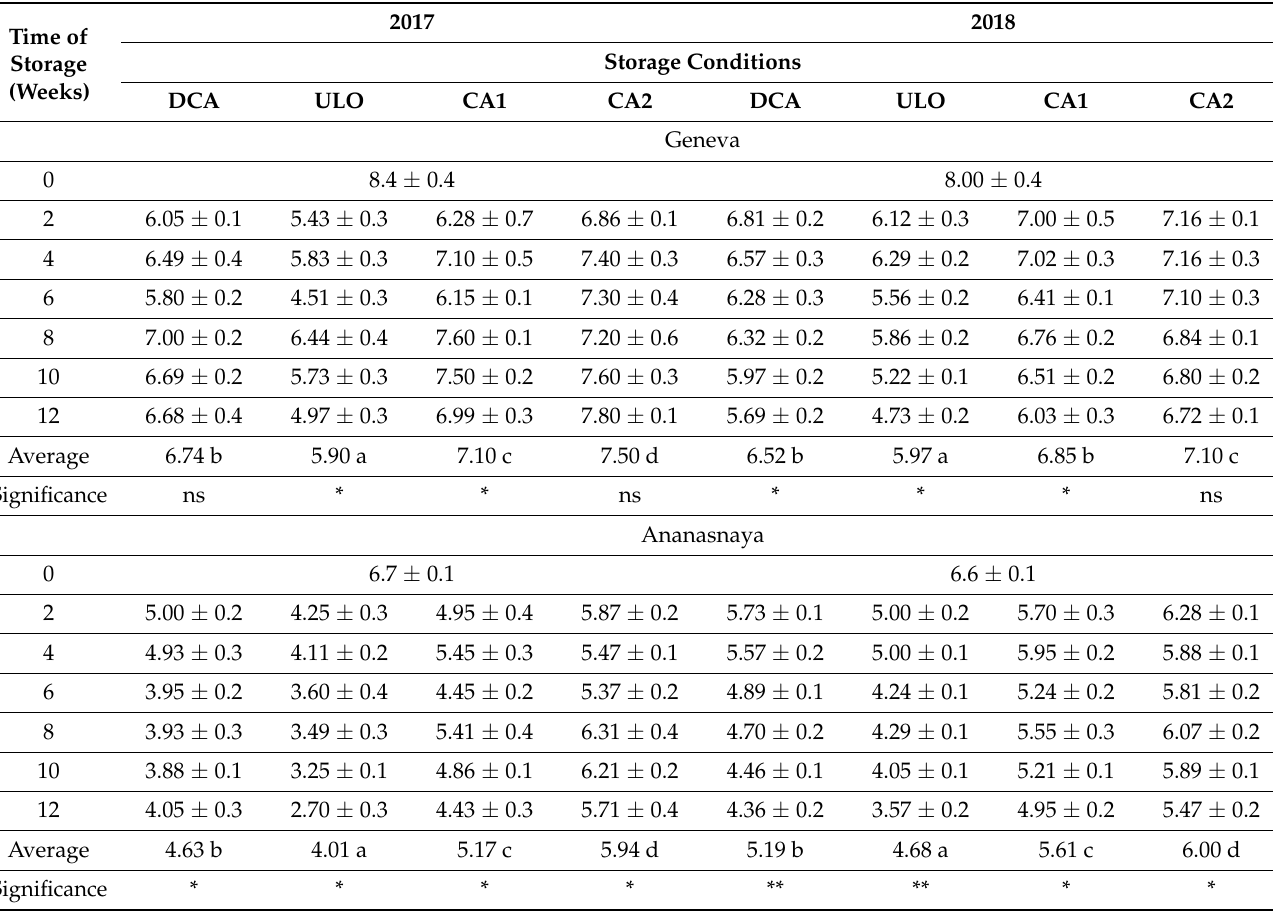
Table 3. Changes in sucrose contents (g · 100 g − 1 F.W.) measured in ‘Geneva’ and ‘Ananasnaya’ minikiwi fruits in the postharvest